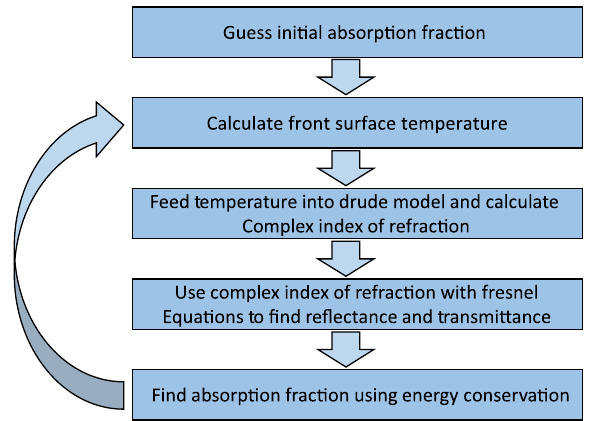
FIG. 6. A schematic overview of algorithm used to calculate reflection, transmission, and absorption is shown.